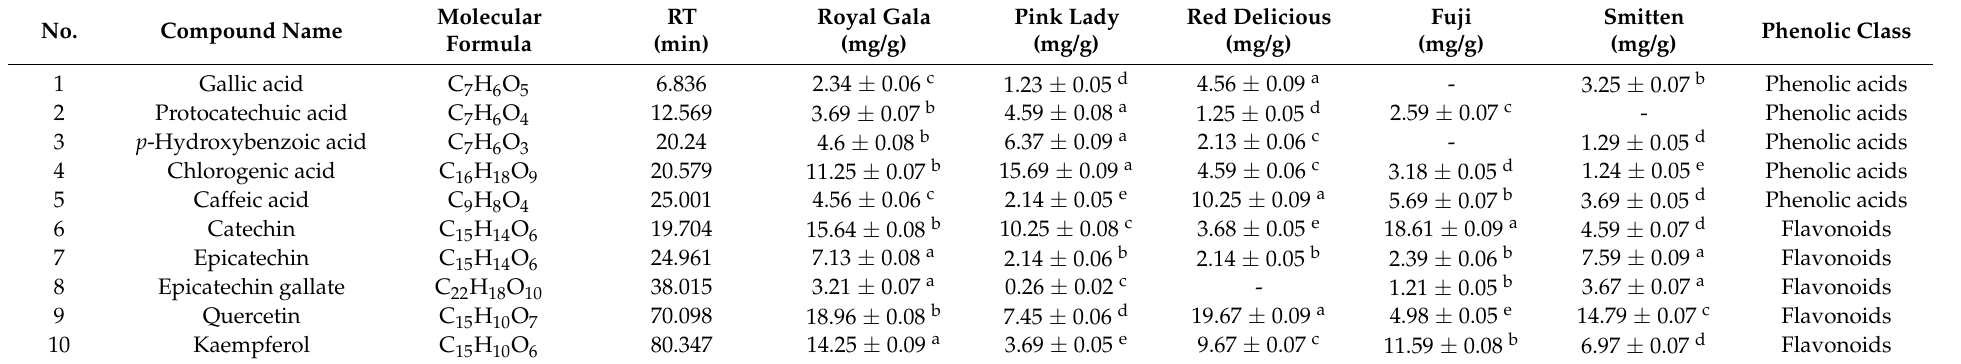
Table 4. Quantitative analysis in phenolic compounds of five kinds of apple